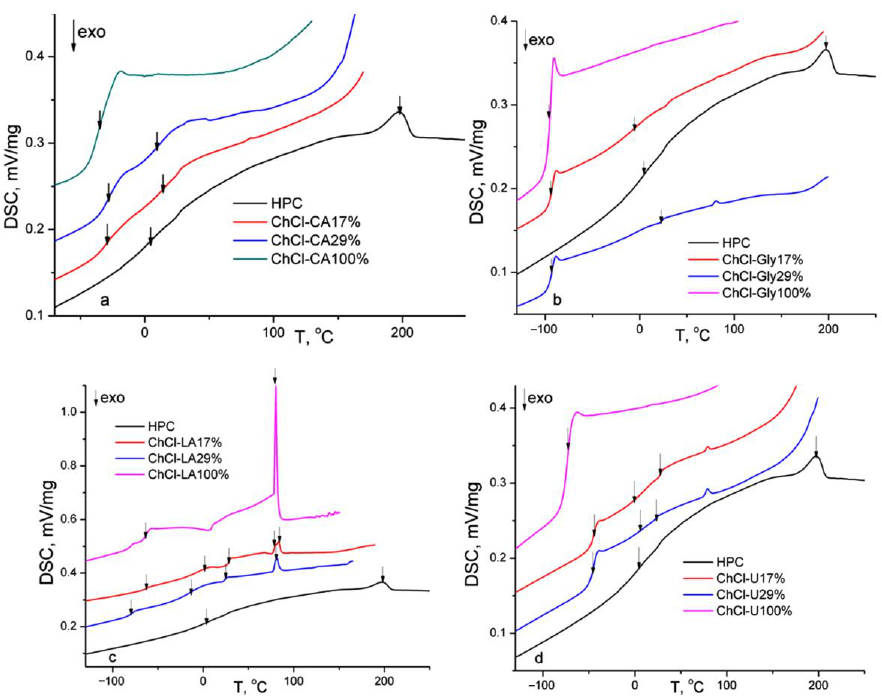
Figure 8. DSC thermograms (second heating runs) of HPC, NADES and HPC-NADES gels (17% and 29% w / w ). Table 4. DSC results (second heating runs) of HPC, NADES and HPC-NADES gels (17% w / w ).